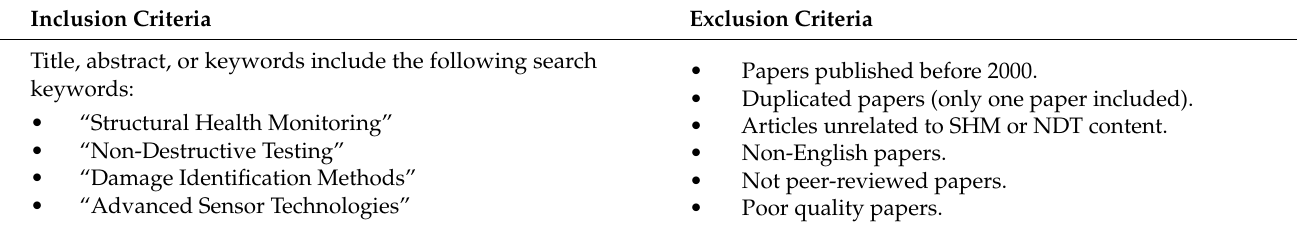
Table 3. Exclusion and inclusion criteria for selecting the reviewed articles.